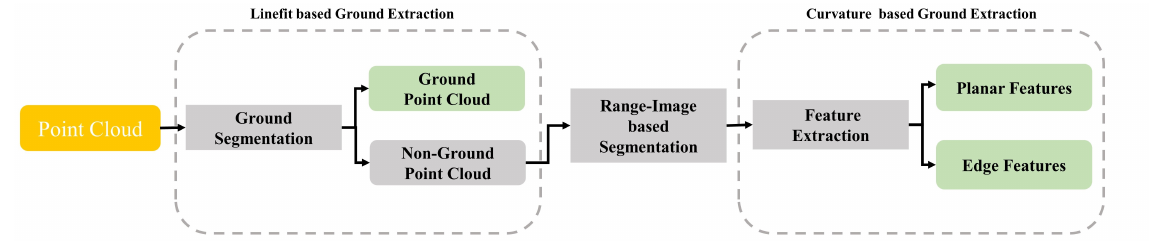
Figure 5. LiDAR feature extraction flowcart. Among them, the yellow represents the input, and the green represents the output result. The gray rectangle represents the processing process, and the rounded rectangle represents the variable.